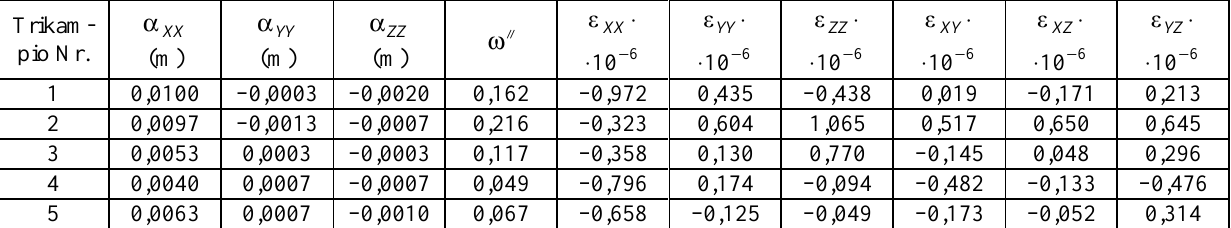
Table 2. Parameters of deformations